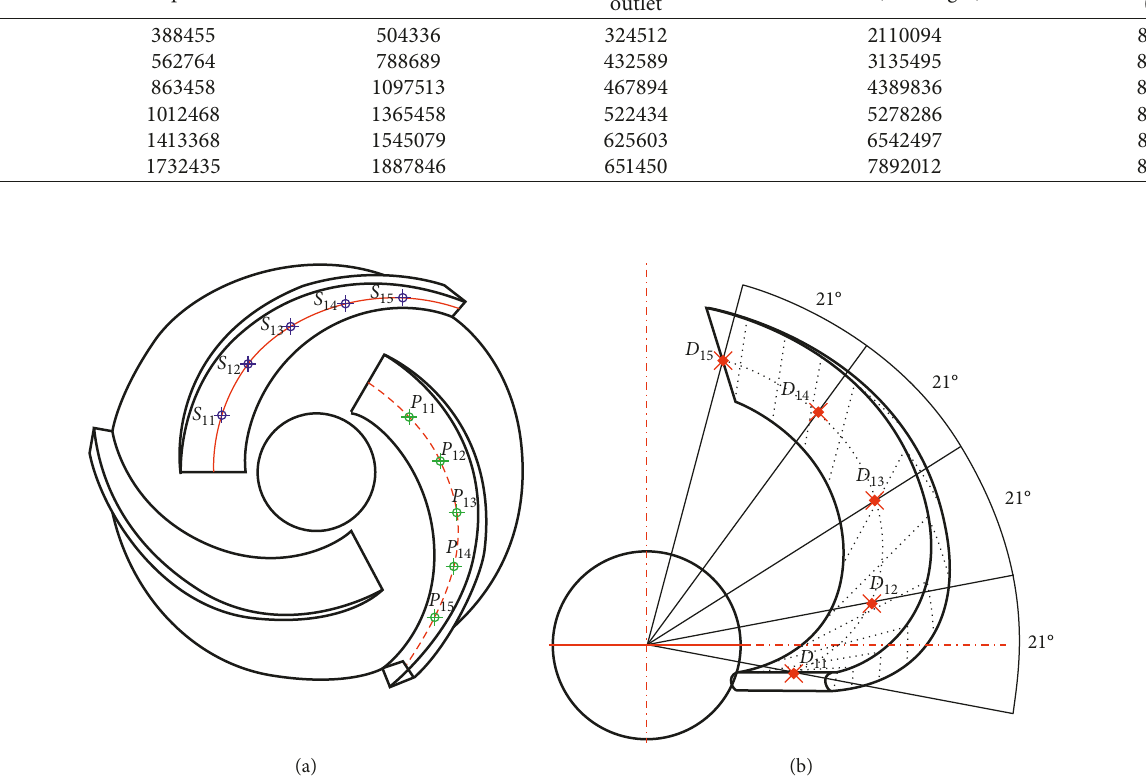
Figure 5: Monitoring point positions inside the (a) impeller and (b) diffuser.